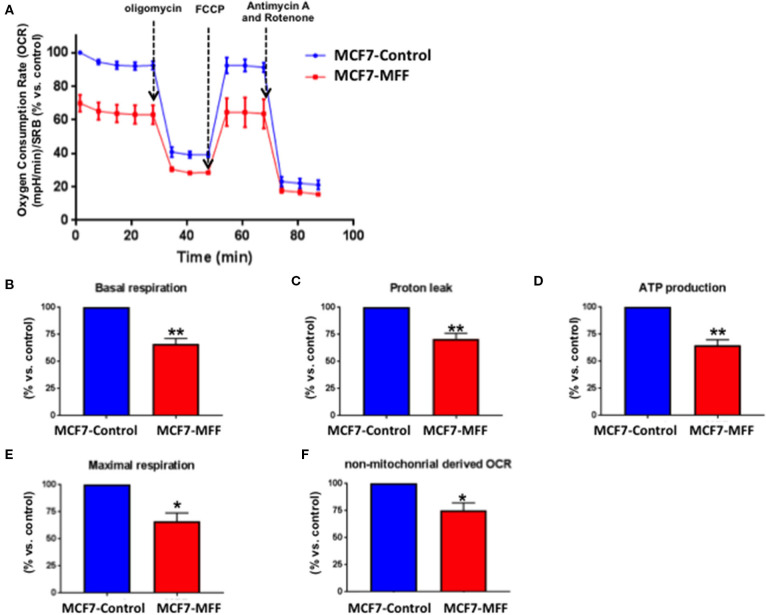
Mitochondrial fission factor (MFF) reduces mitochondrial respiration. The metabolic profile of stably transduced MCF7 cells harboring MFF (MCF-MFF) and the respective empty-vector (MCF-7 Control) was examined using the Seahorse XFe96 analyzer. (A) Oxygen consumption rate (OCR) is significantly reduced in cells transduced with MFF as compared to control cells. (B–F) Significant reductions in respiration (basal and maximal), proton leak, ATP levels and non-mitochondrial derived OCR were observed in MCF7 cells transduced with MFF as compared to the control cells. At least six replicates were performed in each experiment. Results are the average of the mean of three independent experiments and are expressed as percentages normalized to the control ± SEM. *p < 0.05, **p < 0.01.